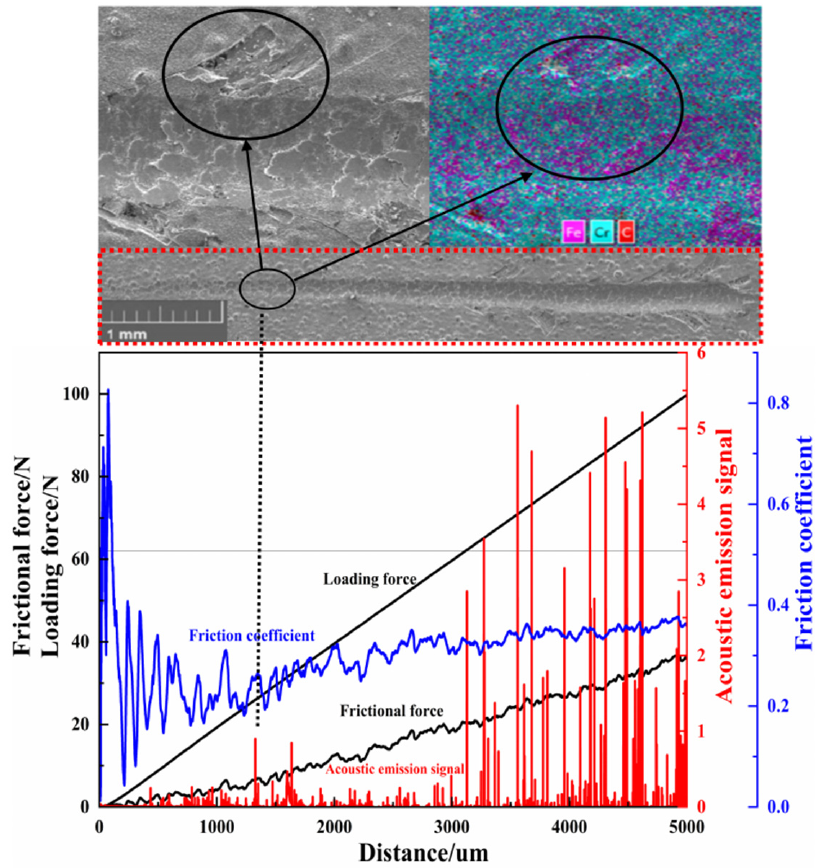
Figure 6. Scratch analysis of the chrome coating.